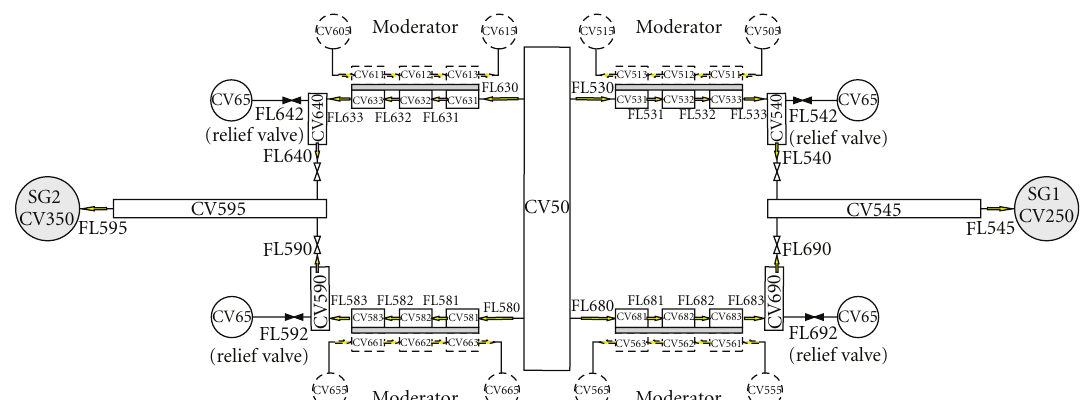
Figure 9: MELCOR nodalisation scheme of feed water systems 10 to